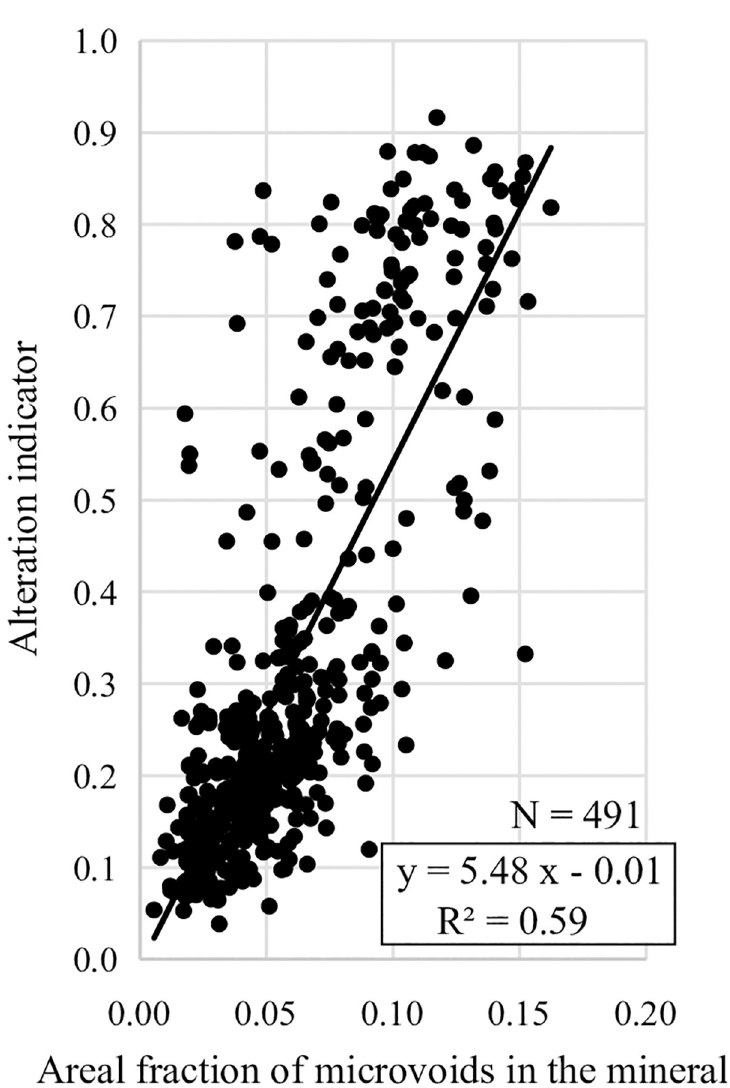
Fig 7. Relationship between the areal fraction of microvoids (microscopic fractures and micropores) in the chloritized biotites and the corresponding alteration indicator (N =